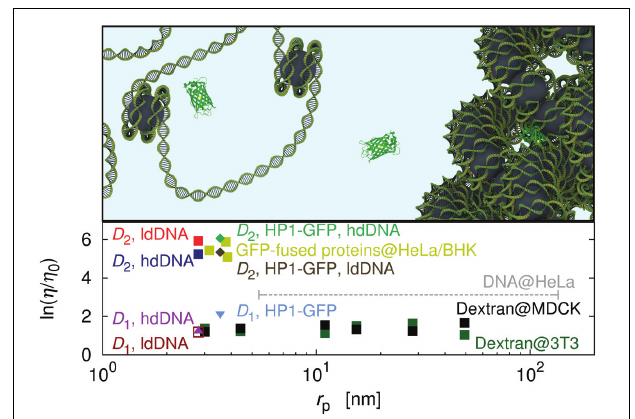
FIGURE 4 | Effective viscosity experienced by the probes diffusing in the cell nucleus [40, 42, 44, 59, 60]. Data for DNA fragments diffusing in the nucleus of the HeLa cell [42], are represented as the dashed line and corresponds to the average value calculated for the fragments of hydrodynamic radii in the range of 5–135nm. Data for dextran polymers as probes are represented as black squares (nucleus of the Madin-Darby Canine Kidney Epithelial Cells – MDCK) and green squares (nucleus of Swiss 3T3 cells – 3T3), respectively, [40]. Data for proteins fused with GFP and moving in the nucleus of the HeLa and of the Baby Hamster Kidney (BHK) cells are marked by yellow squares [44]. The plot shows also data for the EGFP in the nucleus of Chinese Hamster Ovary (CHO) cells [59]. The data for EGFP reveal the heterogeneous structure of the nucleus. Hinde et al. [59] measure the diffusion in high-density DNA (hdDNA) and low-density DNA (ldDNA) regions. In both cases they obtain two diffusion coefficients, fast and slow ( D 1 , D 2 ) that differ by two orders of magnitude. On the plot we show the effective viscosity corresponding to the D 1 in ldDNA, D 1 in hdDNA, D 2 in ldDNA, and D 2 in hdDNA. The heterogeneous structure of the nucleus is also represented by the data for HP1-GFP diffusing in the nucleus of 3T3 cells [60]. Both the slow and the fast component are comparable with results of Hinde et al. [59]. The top panel shows a cartoon representation of the nucleus as a heterogeneous environment consisting of densely and loosely packed DNA regions. Errorbars not shown to keep the clarity of the figure. Most of errorbars does not exceed an order of